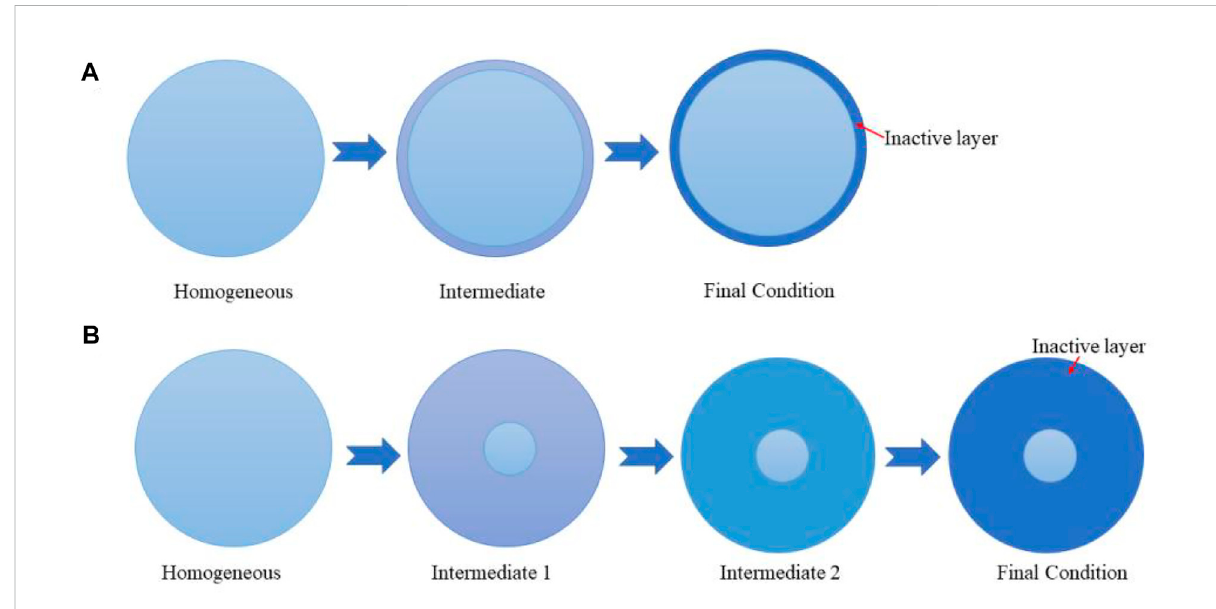
FIGURE 8 SO 2 -poisoning mechanism over MnCe-CP (A) and MnCe-RP (B) . Cited from Zhong et al.